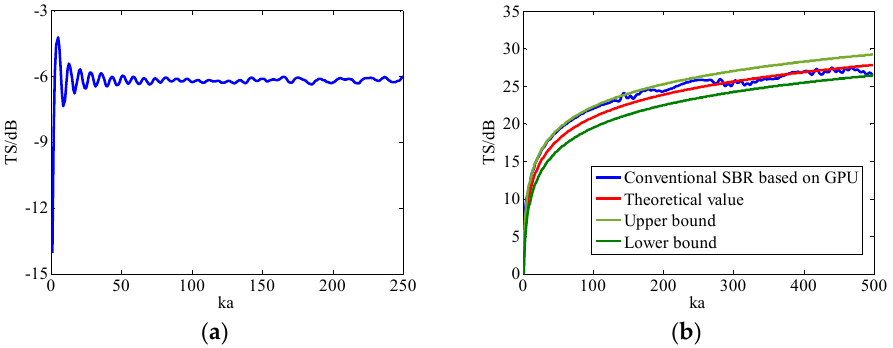
Figure 8. The curve of TS with ka ( θ = 90° ) by conventional SBR algorithm based on GPU. ( a ) A rigid sphere with radius 1 m. ( b ) A rigid cylinder with length 6 m and radius 1 m.